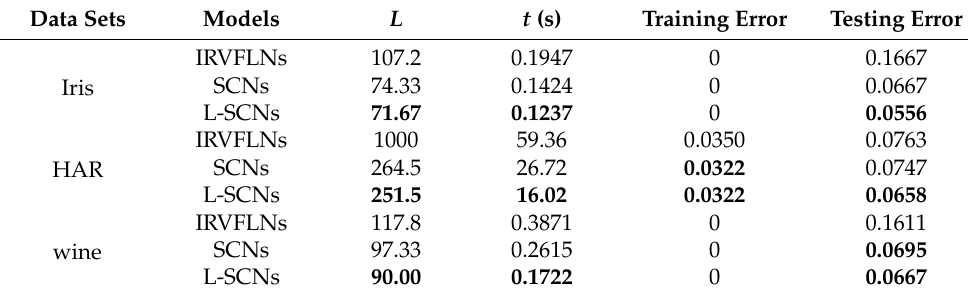
Table 5. Performance comparison for classification data